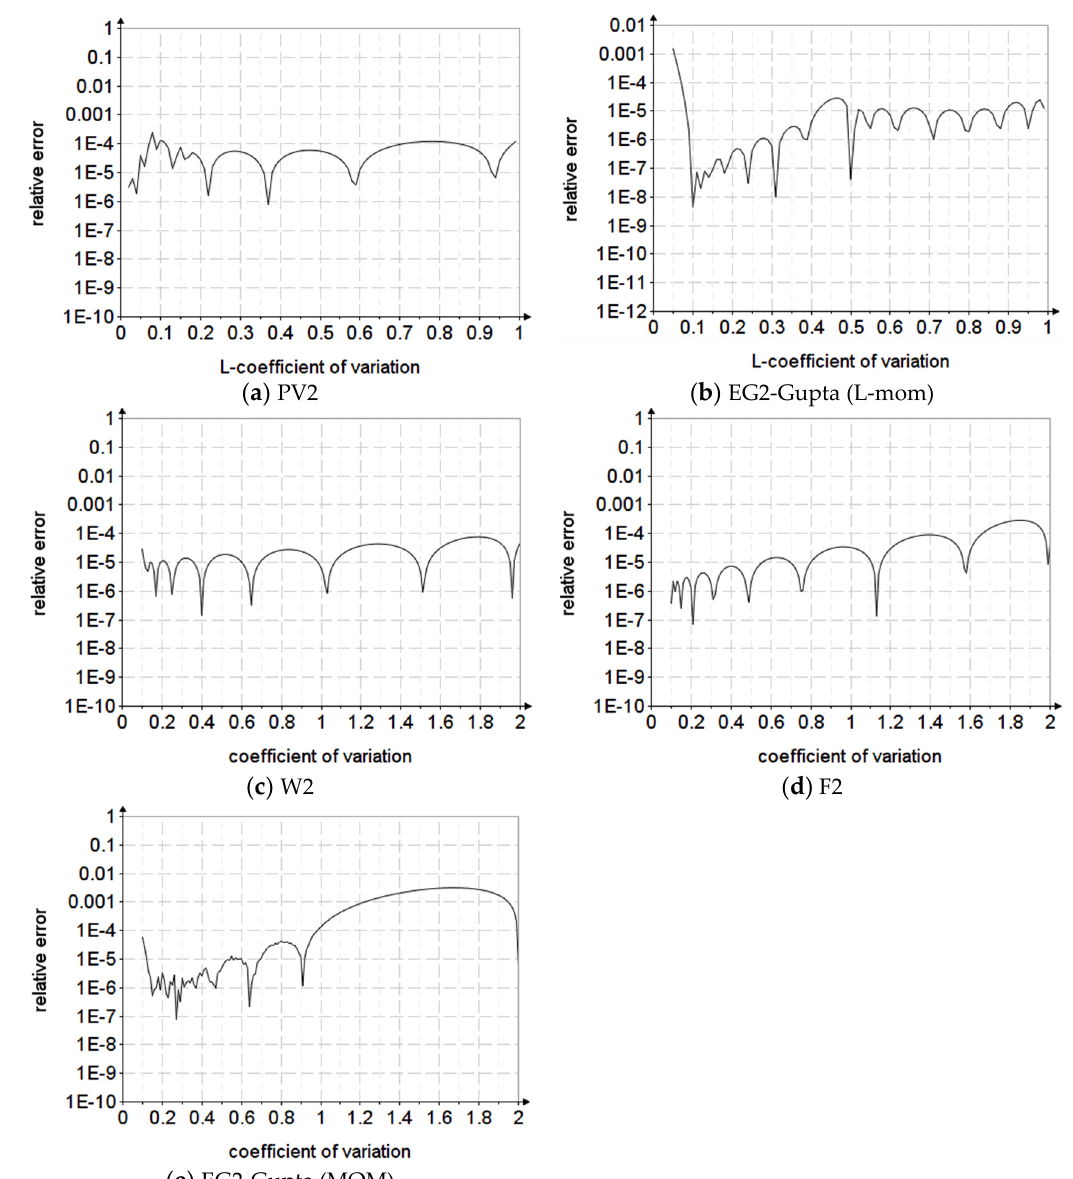
Figure 4. The variation of errors depending on